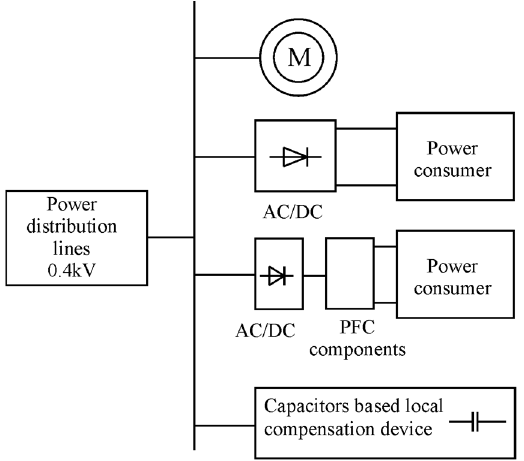
Figure 1. The main loads and local compensation device used in 0.4 kV power distribution lines in the re-searched arena building.